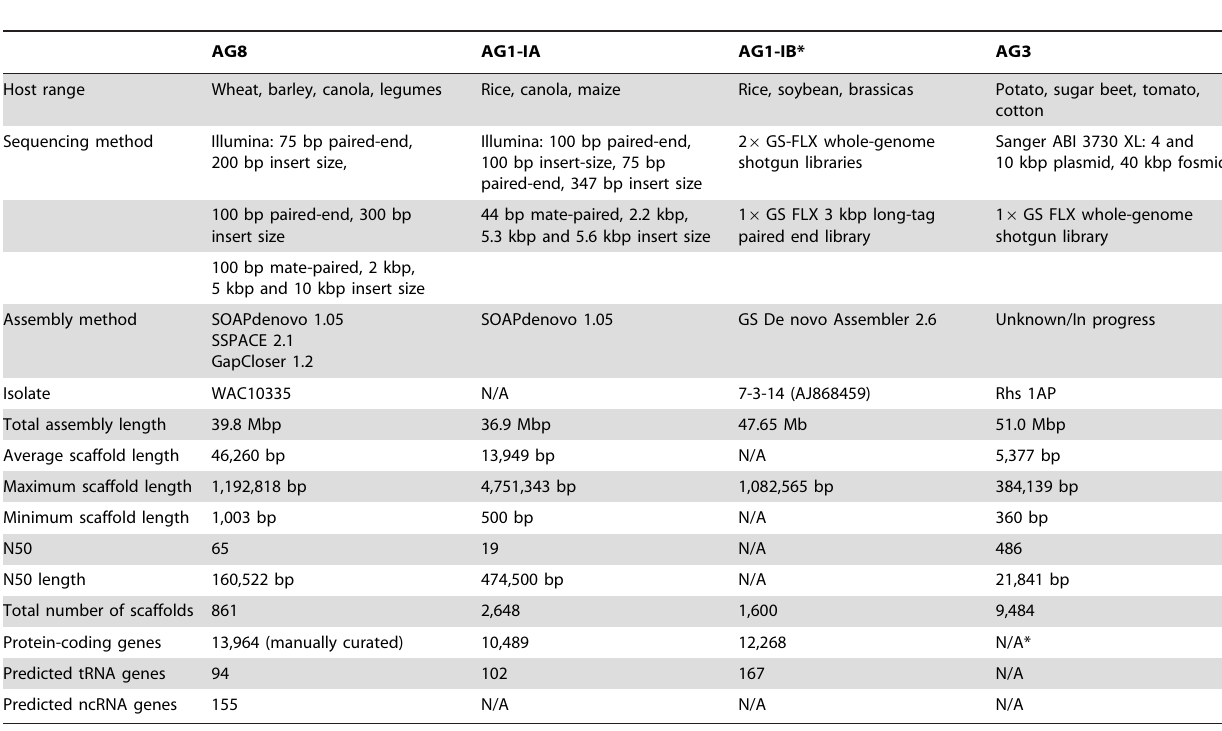
Table 1. Assembly statistics of four draft genome assemblies of R. solani